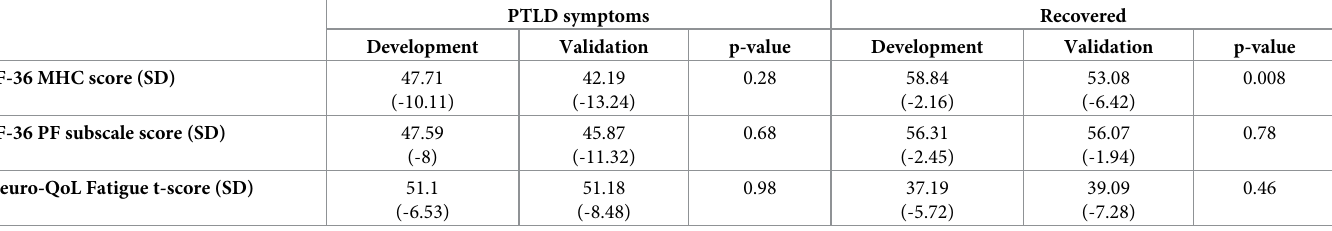
Table 3. Comparison of the mean scores used in the mean scores used in the Logistic Regression and Decision Tree Models between the validation and development